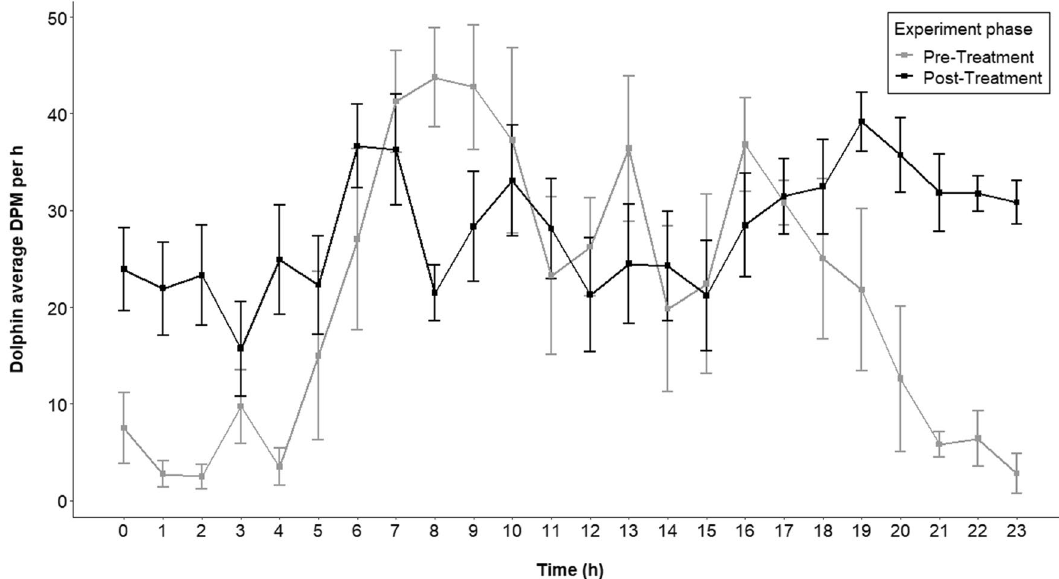
Figure 6. Average dolphin presence recorded in a day in the pingered CPOD during the pre-treatment and post-treatment phase of 6 and 12 days,